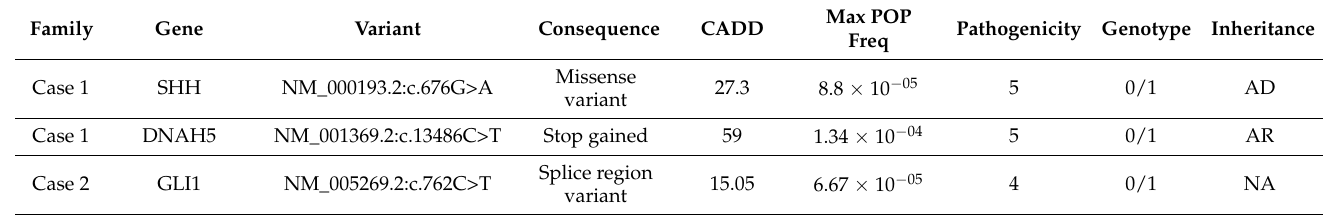
Table 1. Syndromic inherited retinal dystrophy candidate genes captured by GLOWgenes that hold pathogenic/likely pathogenic variants and fulfill phenotype in cases analyzed by WES. Variant pathogenicity is coded according to ACMG guidelines as: 1 (benign), 2 (likely benign), 3 (uncertain significance), 4 (likely pathogenic), and 5